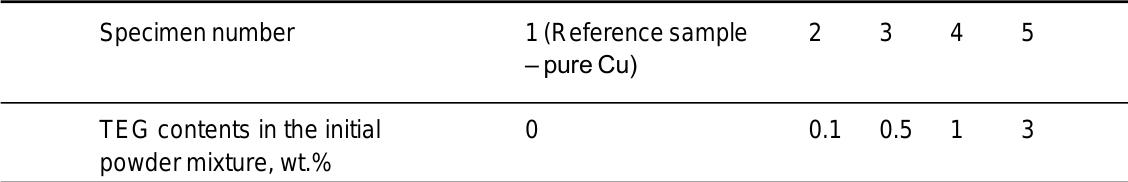
Table 1. Composition and numeration of the